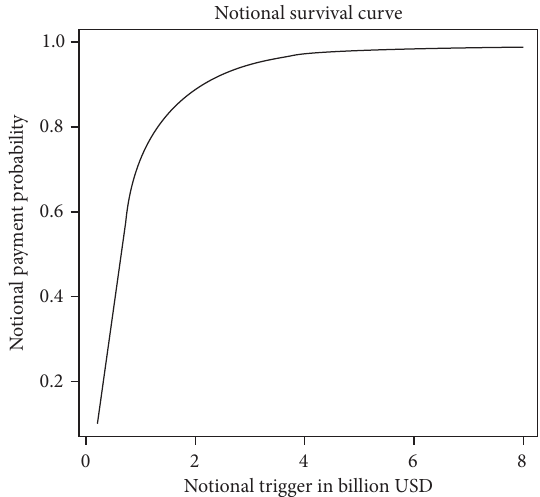
Figure 17: Cyber bond notional survival curve for 3years.